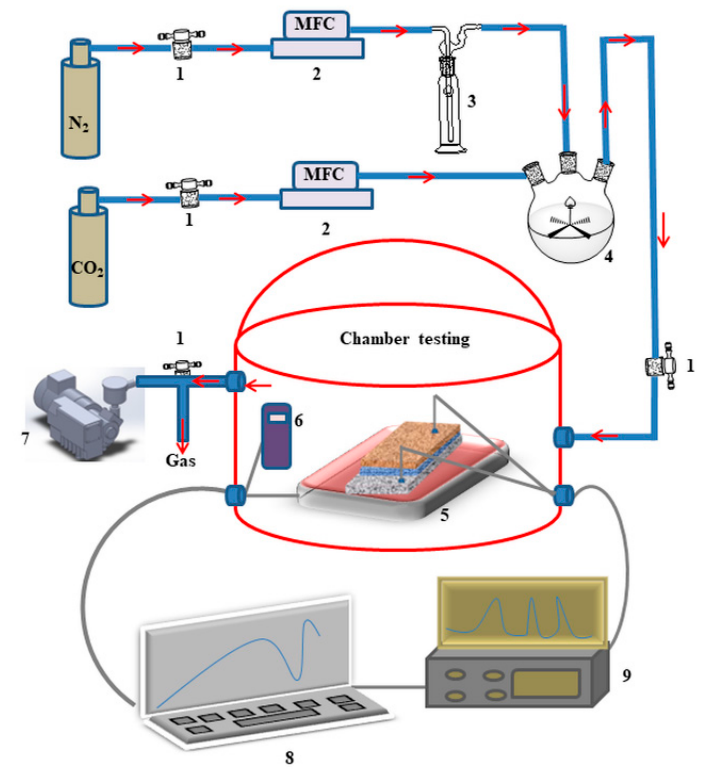
Figure 2. Schematic diagram of sensors testing: (1) valves; (2) mass flowmeter; (3) humidifier; (4) gas mixing chamber; (5) heater and temperature controller; (6) humidity sensor; (7) vacuum pump; (8) PC—data acquisition and processing; (9) Keithley 2450